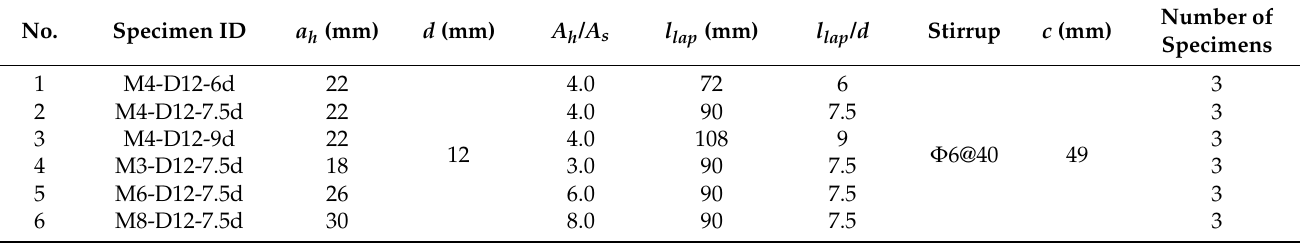
Table 1. Details of specimens for test.